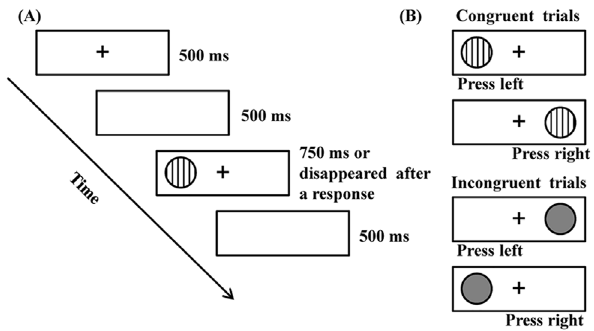
Fig 1. Stimulus and procedure in the Dots task. (A) The time procedure in each trial for the task. (B) Two types of dots were used in the task.